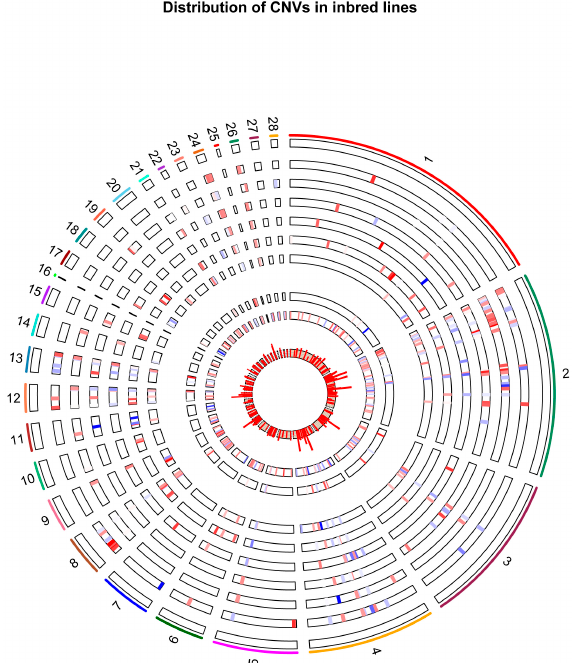
Figure 1. Circos plot illustrating CNV regions in eight inbred chicken lines (two F1 were not included). Regions with copy number events are plotted within the gray inner circle. Copy number changes indicated by segment mean log 2 Ratio values are shown in the inner circle plot using the RCircos.Heatmap.Plot function in RCircos package. The outermost circle displays the chicken chromosomes (chrZ and chrW were excluded). The circles from inside to outside represent Lines 72, 63, RCS C, J, M, N, S and X. The bin heights in the inner circle represent the frequencies of CNV segments.